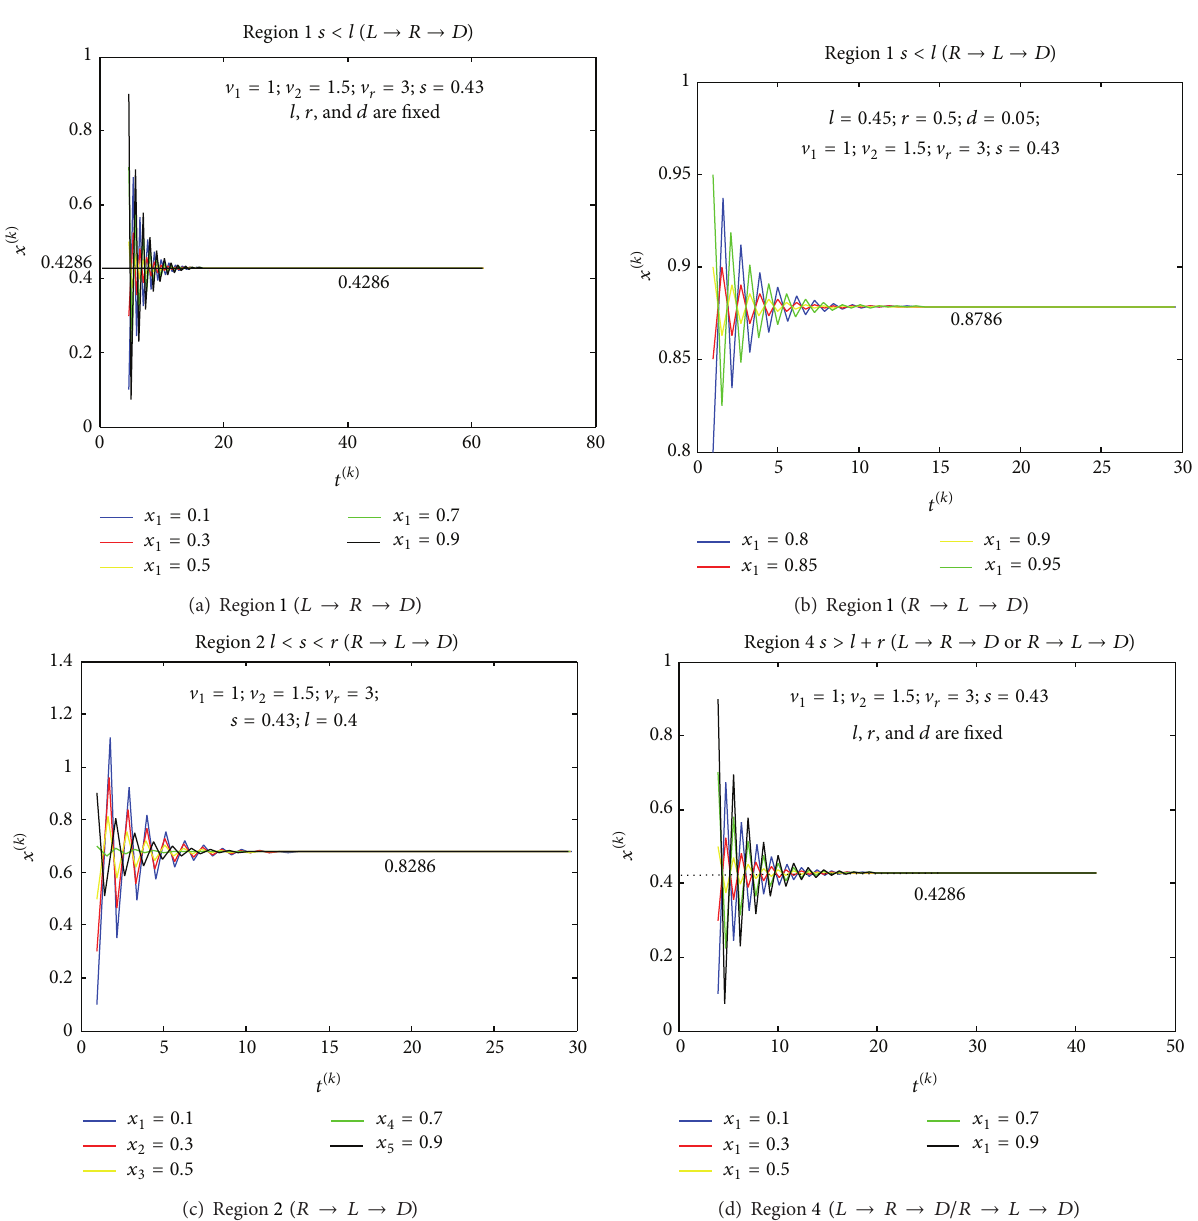
Figure 7: Effect of initial location on system’s stable